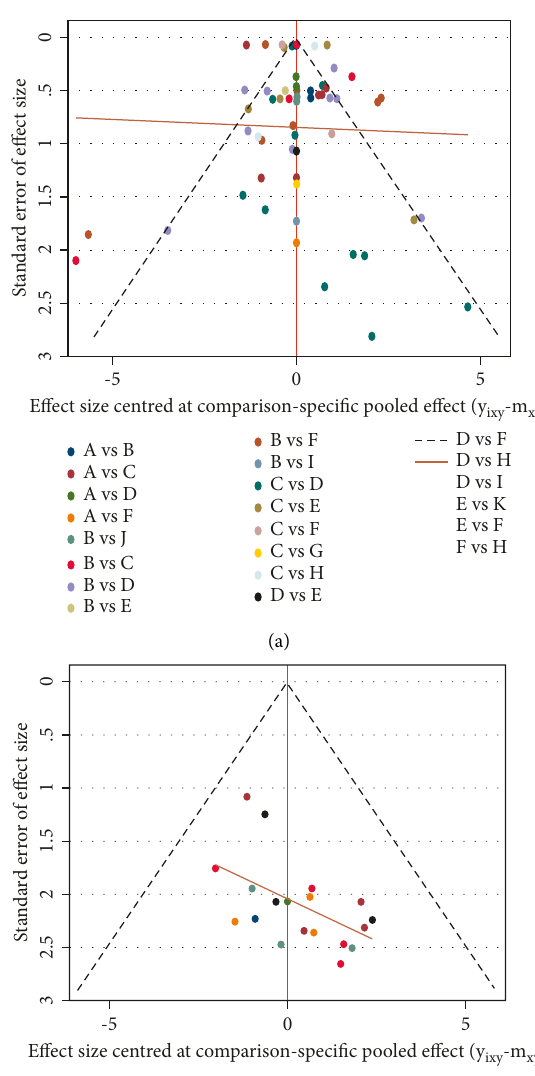
Figure 13: Funnel plot. ((a) flow-mediated dilation, (b) brachial artery diameter) A, placebo; B, CCB (calcium channel blockers); C, ACEI (angiotensin-converting enzyme inhibitors); D, ARB (angiotensin receptor blocker); E, β -blocker; F, diuretic; G, CCB + β -blocker; H, ACEI+ ARB; I, ARB +CCB; G, ACEI